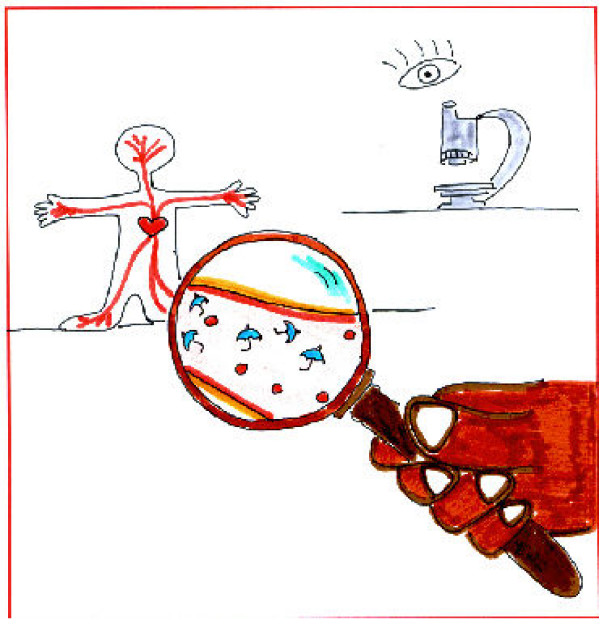
Picture from the booklet used to explain HIV/AIDS to children. The booklet is used by caregivers and health center staff. This picture is used to explain "what actually is blood ?" to the child.